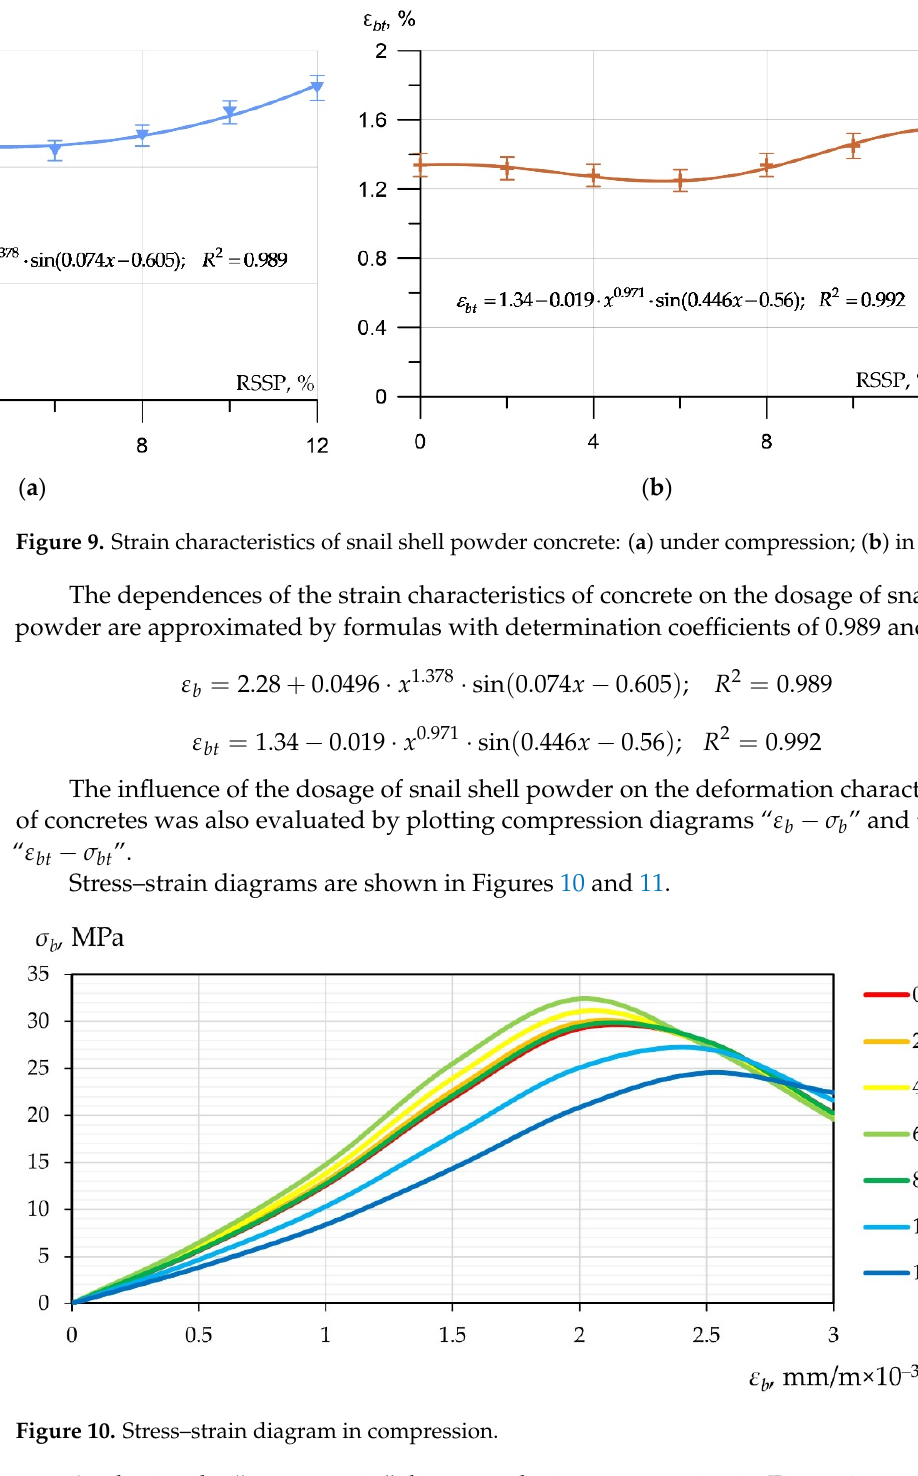
Figure 10. Stress–strain diagram in compression. Analyzing the “stress–strain” diagrams during compression in Figure 9, we can con- clude that the best properties are characteristic of concrete nanomodified with snail shell powder in the amount of 6%. The “peak of its diagram is shifted upwards and to the left relative to other diagrams, which indicates its high strength and low deformation charac- teristics”. Concrete has the worst deformation characteristics, “in which 12% of the cement was replaced by the powder of snail shells”. This is due to the oversaturation of concrete with a nanomodifying additive in excess of its rational amount. Thus, the peak of the stress– strain diagram at a dosage of 12% RSSP is shifted to the right and down relative to